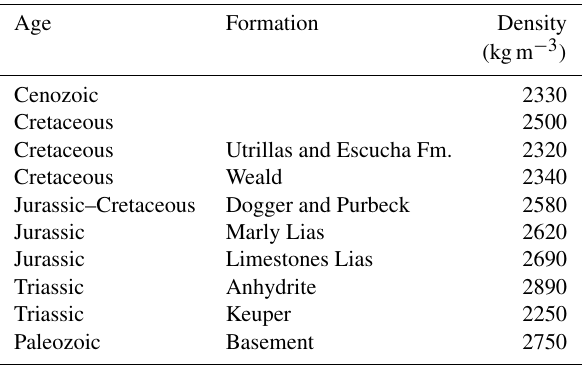
Table 1. Formation densities used in the gravity modelling and con- straints for the inversion of the microgravity